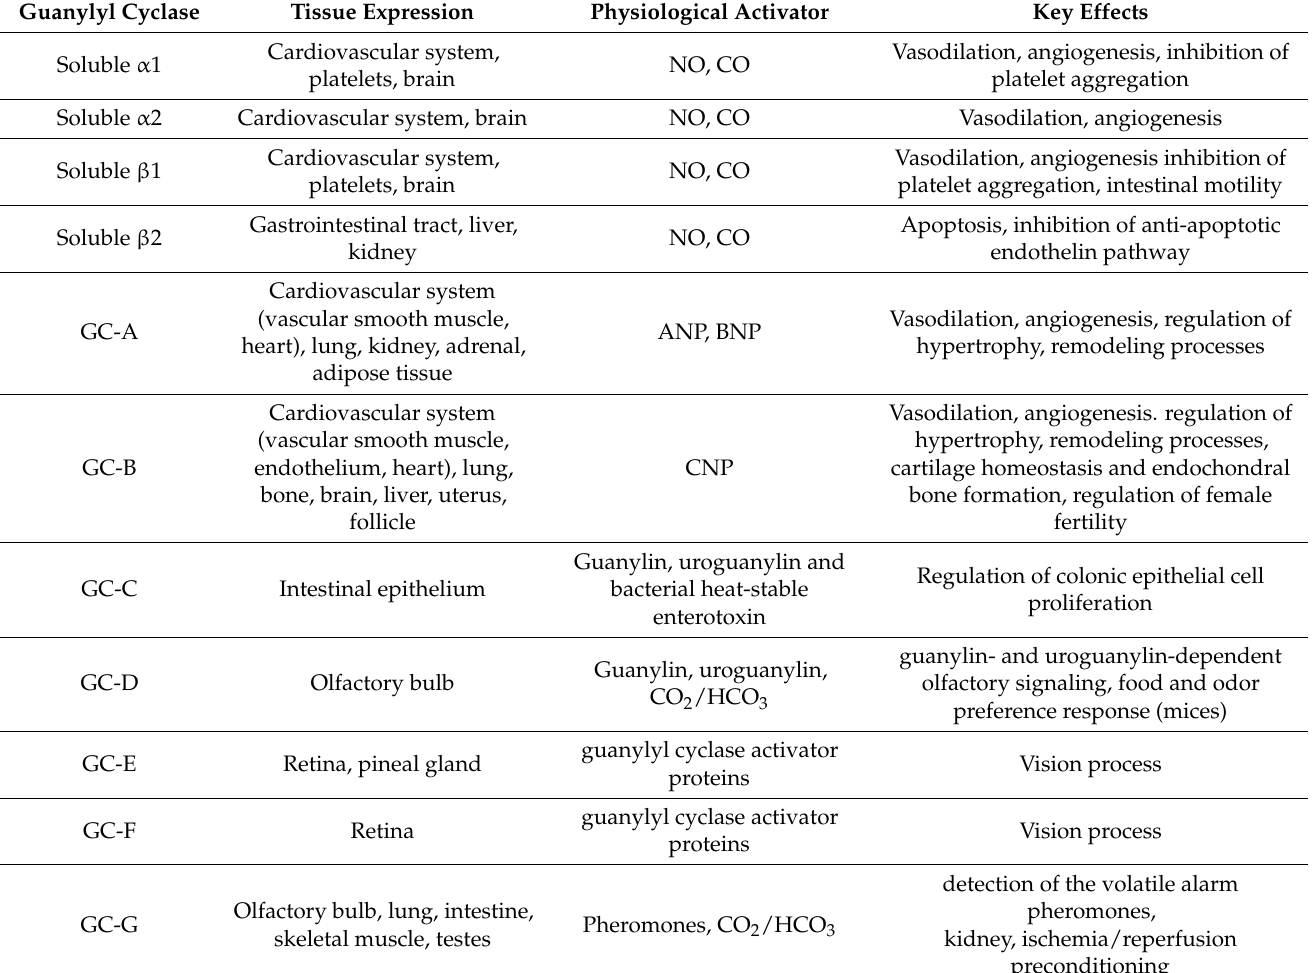
Table 1. Guanylyl cyclases: activators, tissue expression and physiological